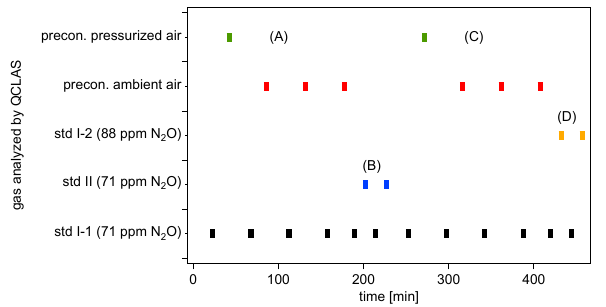
Fig. 2. Measurement cycle: (A)+(C) analysis of ambient air or pressurized air (target gas), (B) determination of calibration factors for δ 15 N α , δ 15 N β , and (D) the N 2 O mixing ratio as well as its in- fluence on δ values.